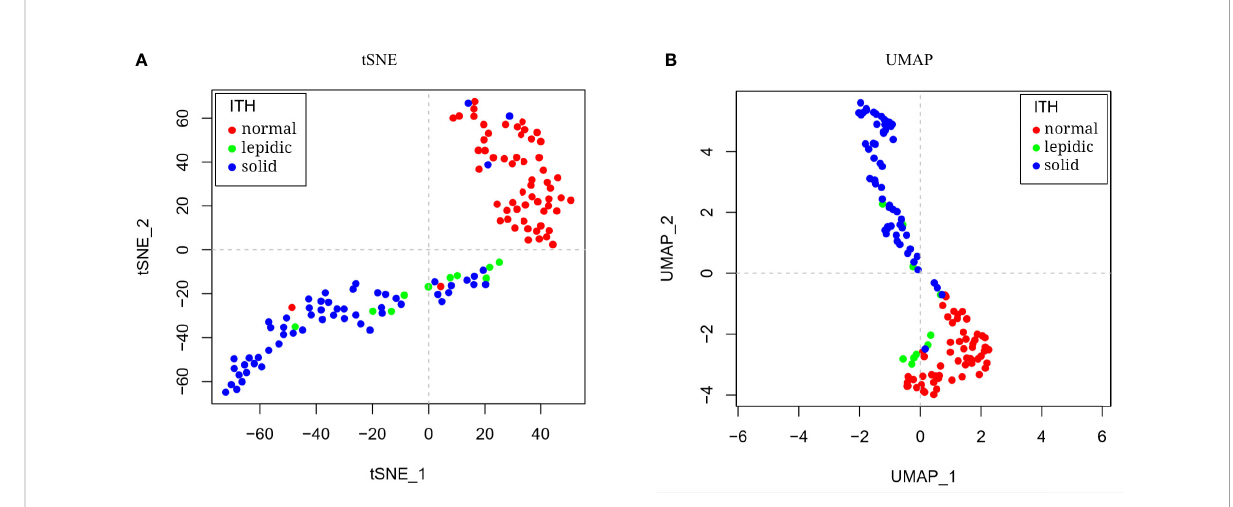
FIGURE 2 Dimension reduction and visualization of histologic subtypes. The LUAD samples showed separate distribution by (A) tSNE and (B) UMAP dimension reduction on transcriptional pro fi